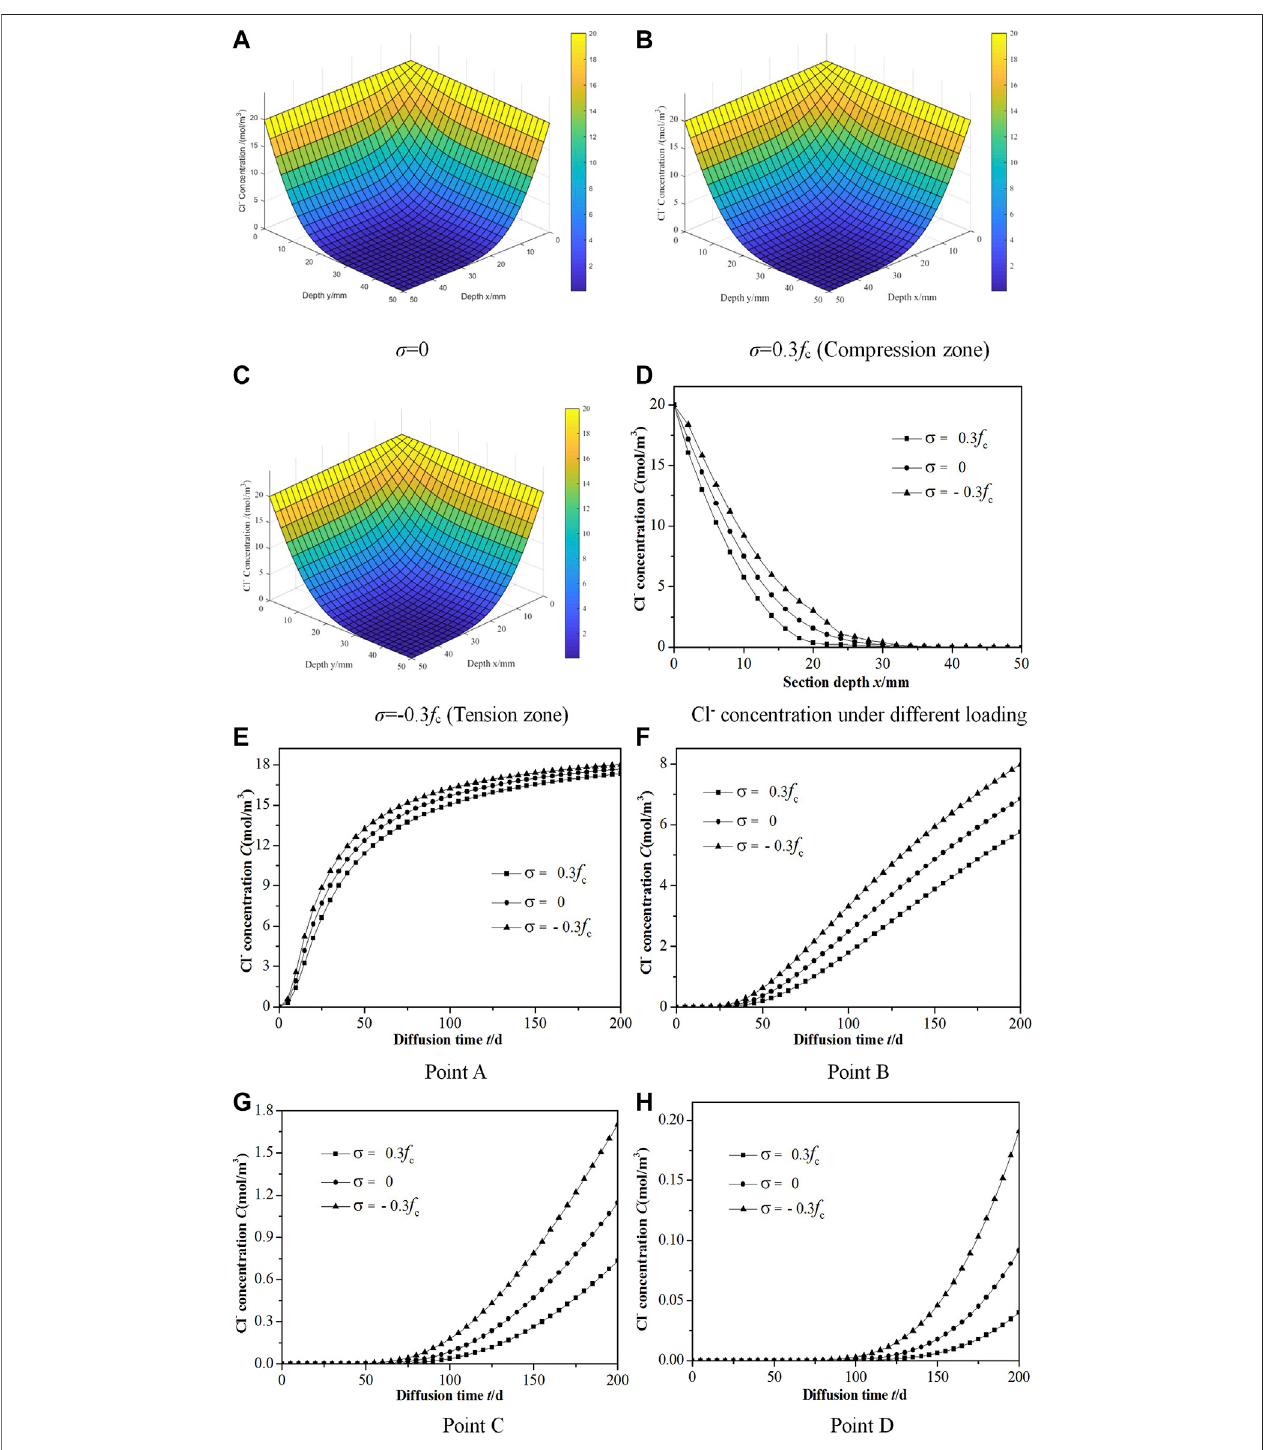
FIGURE 11 | Distribution of Cl − concentration in concrete under different